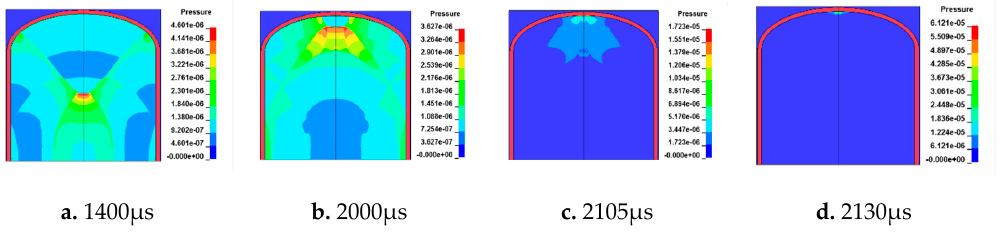
Figure 6. Internal explosion nephogram under the 8g charge.